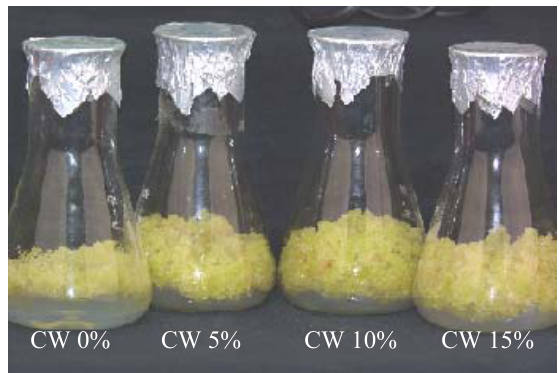
FIGURE 3. Calli proliferation under CH 300 mg/L at different CW levels, after 12 weeks of